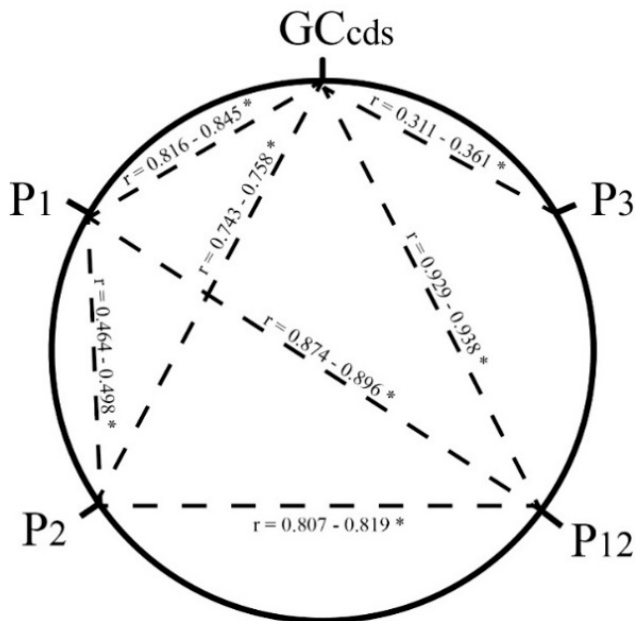
Figure 2. Correlation analysis among GC contents in twelve Solanum chloroplast genomes. The GC content of the coding sequences (GC cds ), the first (P 1 ), the second (P 2 ), and the third (P 3 ) codon positions, and the average value of P 1 and P 2 (P 12 ) are shown. The dotted lines represent the significant correlation with the asterisk (* p < 0.01). The Spearman’s rank correlation coefficients ( r ) are 0.816–0.845 (GC cds and P 1 ), 0.743–0.758 (GC cds and P 2 ), 0.929–0.938 (GC cds and P 12 ), 0.311–0.361 (GC cds and P 3 ), 0.464–0.498 (P 1 and P 2 ), 0.874–0.896 (P 1 and P 12 ), and 0.807–0.819 (P 2 and P 12 ). The indices without lines indicate that their pairwise analysis did not detect any significant correlation. The GC content at the position P 3 did not show a significant correlation with those at P 1 , P 2 , and P 12 , which suggests that the